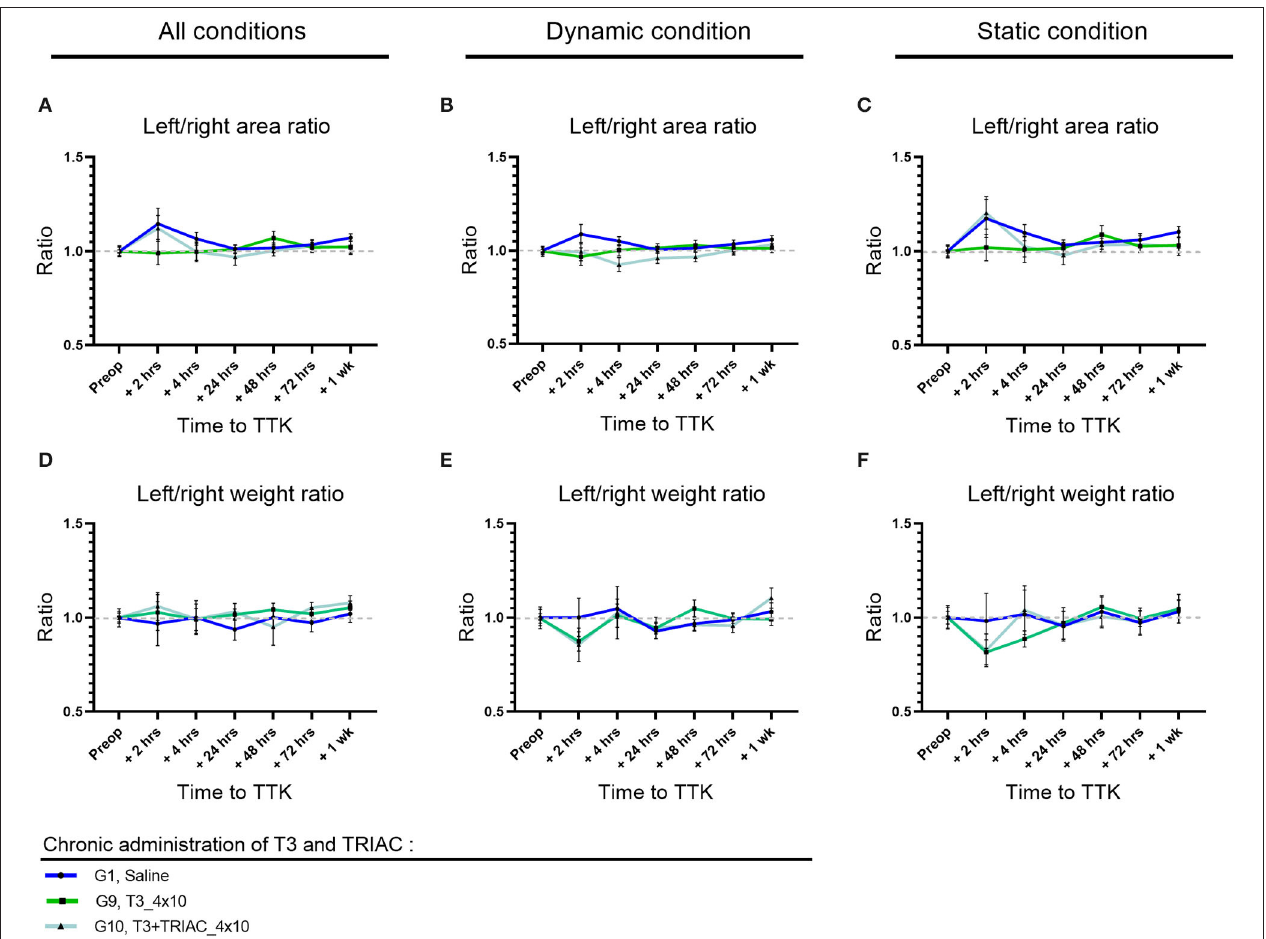
FIGURE 7 | Effect of T3 treatment on left/right area (A–C) and weight (D–F) ratio in vestibular defective rats. Postural balance is assessed for all conditions (A,D) or under dynamic (B,E) or static conditions (C,F) . T3 treatment shows no significant effect on the considered parameters (Two-way ANOVA, NS). n = 44.